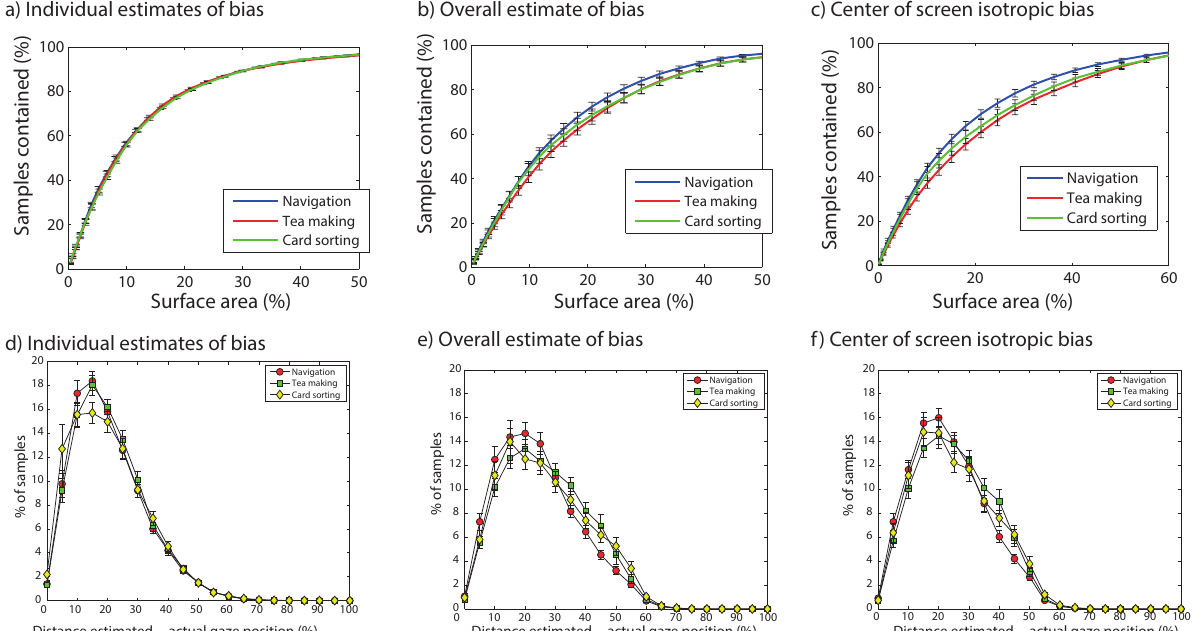
Figure 6 . Estimates of the percentage of gaze points contained within ellipses of various sizes modeling the central bias. Along the horizontal axis the size of the ellipse is shown (as a percentage of the total surface size of the video image; ‘surface area’), whereas on the vertical axis the percentage of gaze points contained in the ellipse is indicated (‘samples contained’). a) Estimates based on ellipses estimated for each participant individually using a baseline task with a mobile eye tracker. b) Estimates based on ellipses based on the present data. c) Estimates based on assuming an isotropic bias (equal standard deviations in both horizontal and vertical directions) towards the center of the image. Lines in the graphs are connecting the individual data points. d, e, and f) Histograms of the distance between the actual gaze position and the estimated gaze position on the basis of the various bias measures (as in a, b and